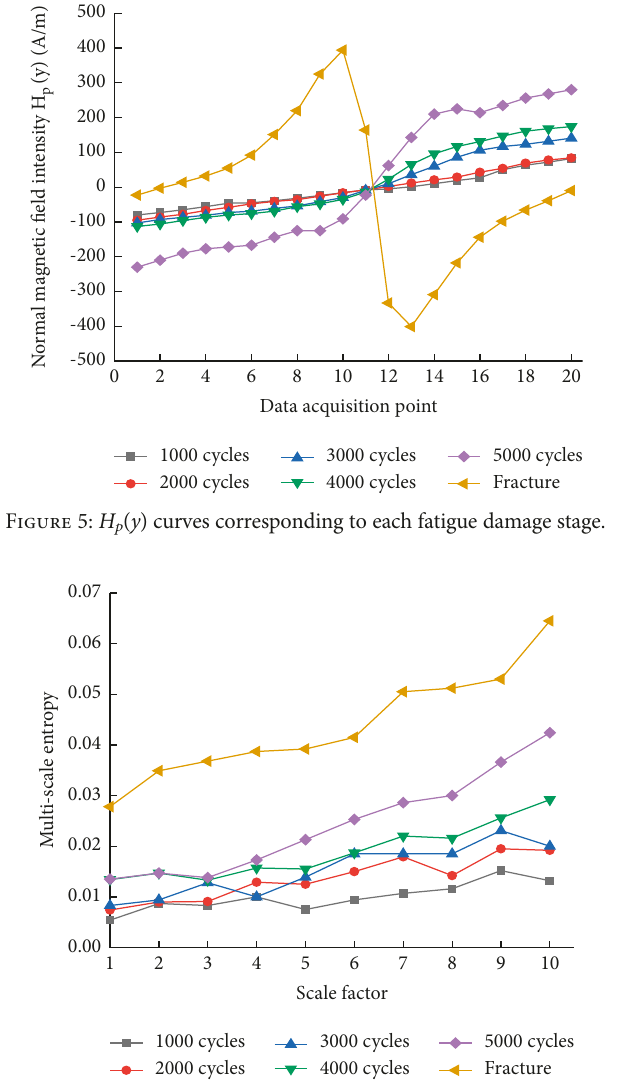
p ( y ) in fatigue damage process.